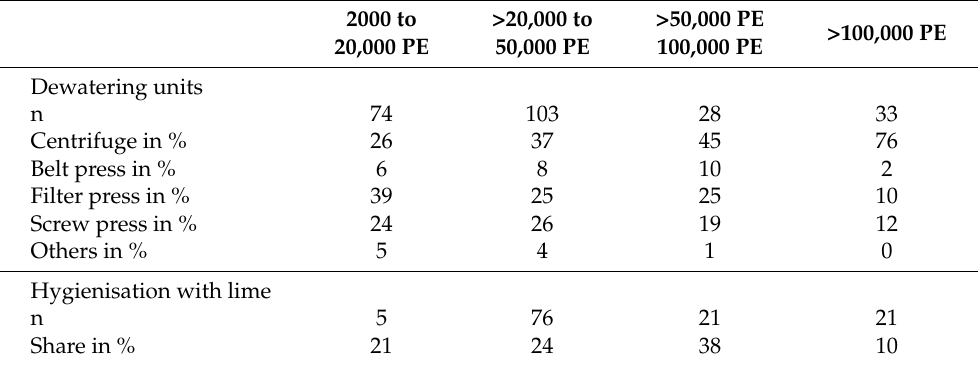
Table 4. Summary table of dewatering units and use of lime according to the size group of the respective wastewater treatment